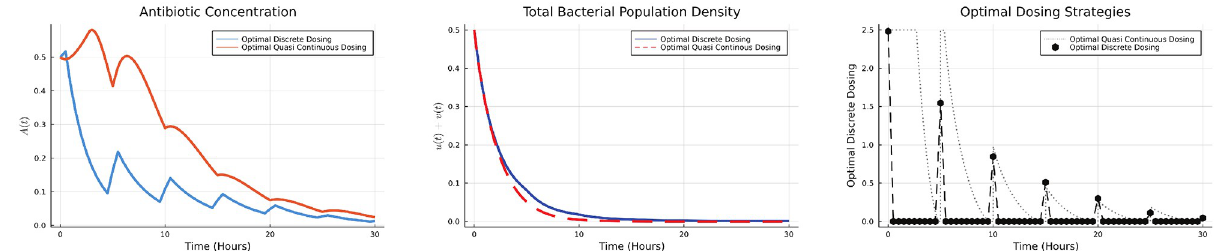
Fig 9. Optimal dosing strategies, bacterial population, and antibiotic concentration.